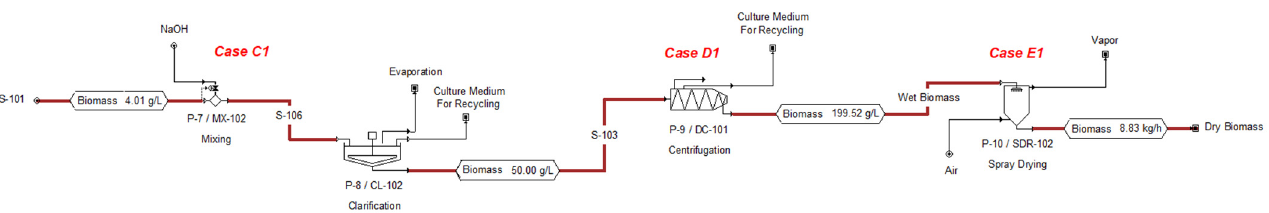
Figure 2. Flowsheet for the cultivation stage (technology B).